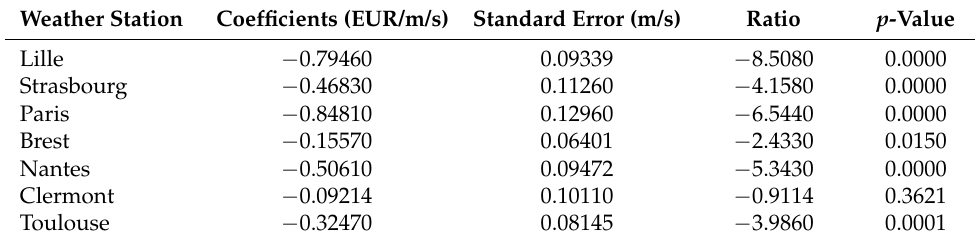
Table 3. Summary of linear components. Weather Station Coefficients (EUR/m/s) Standard Error